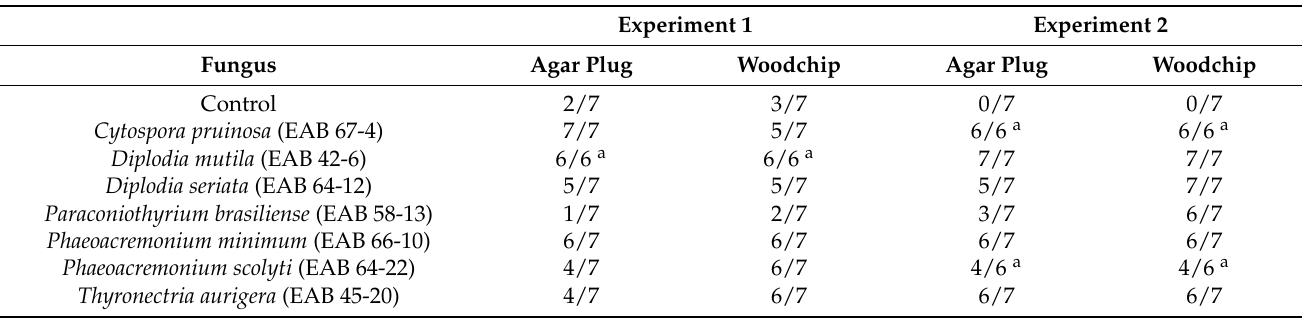
Table 1. Number of trees with measurable lesions as compared to total number of trees used for each treatment in Experiments 1 and 2.